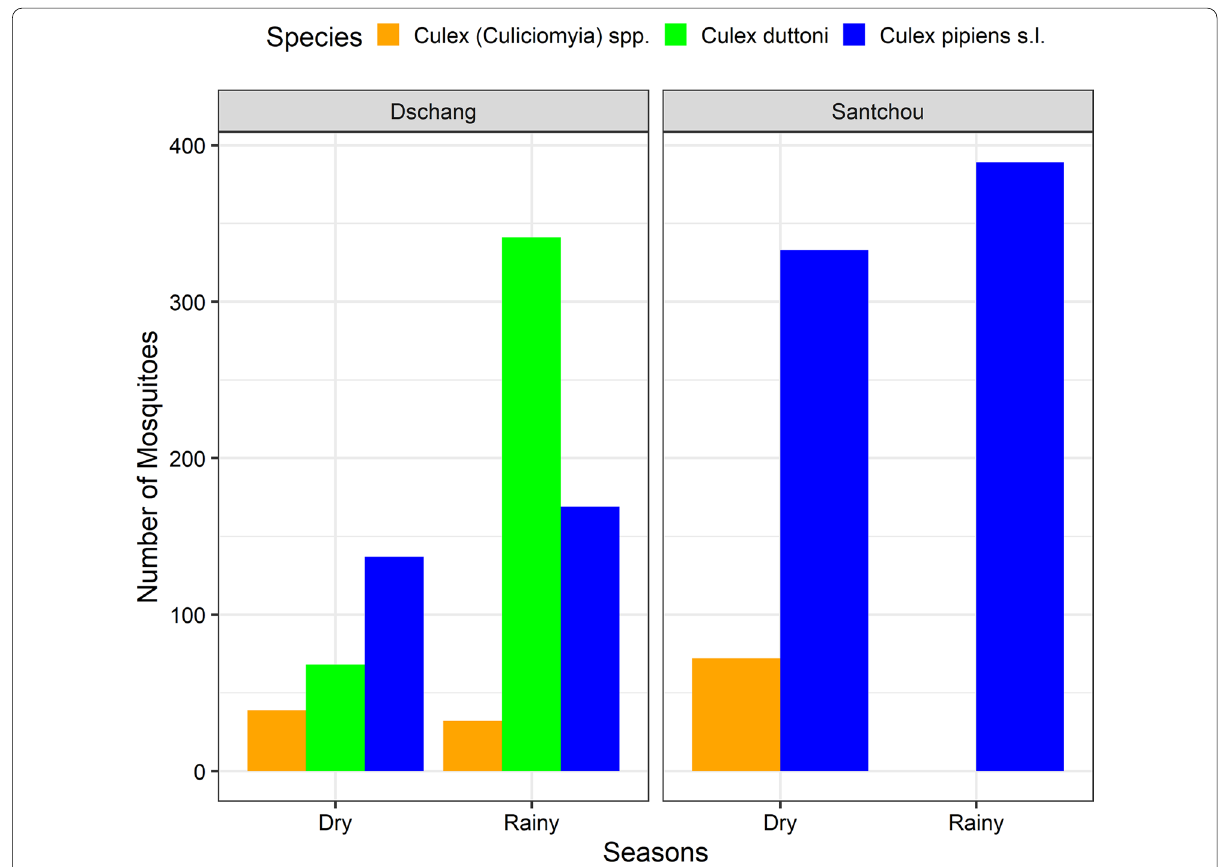
Fig. 5 Abundance and species richness of Culex per season in Dschang and